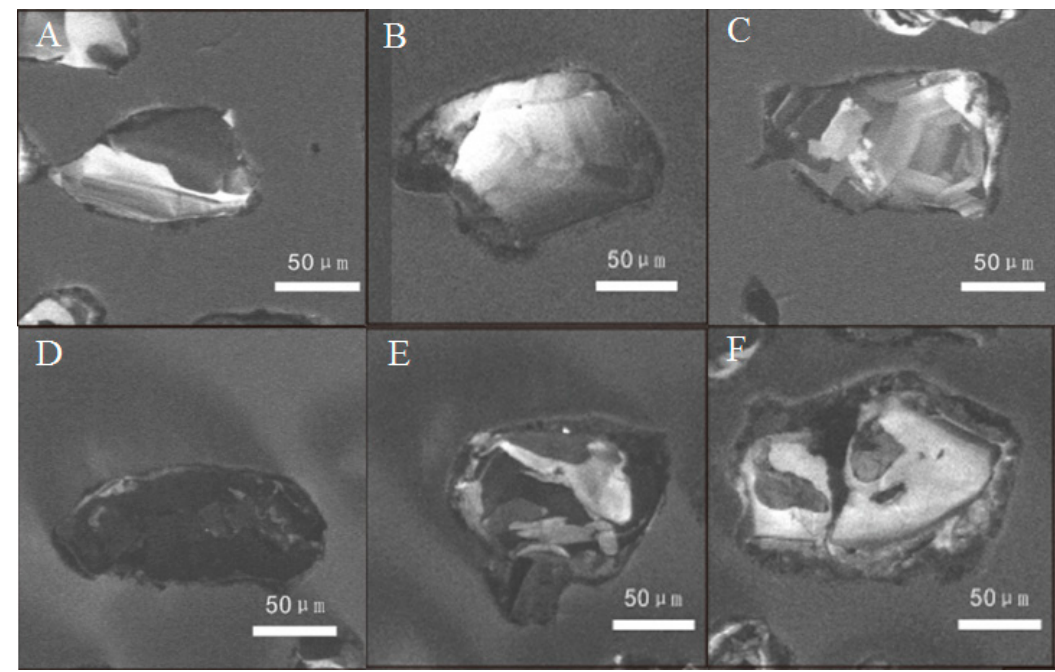
Figure 6. The CL images of zircon in porphyritic granite. ( A – C ) Localized oscillating ring zone of magmatic zircon; ( D ) dark hydrothermal ziron; ( E ) zircon that are sheared or broken into sub-grains; ( F ) broken magmatic zircon with altered edge.